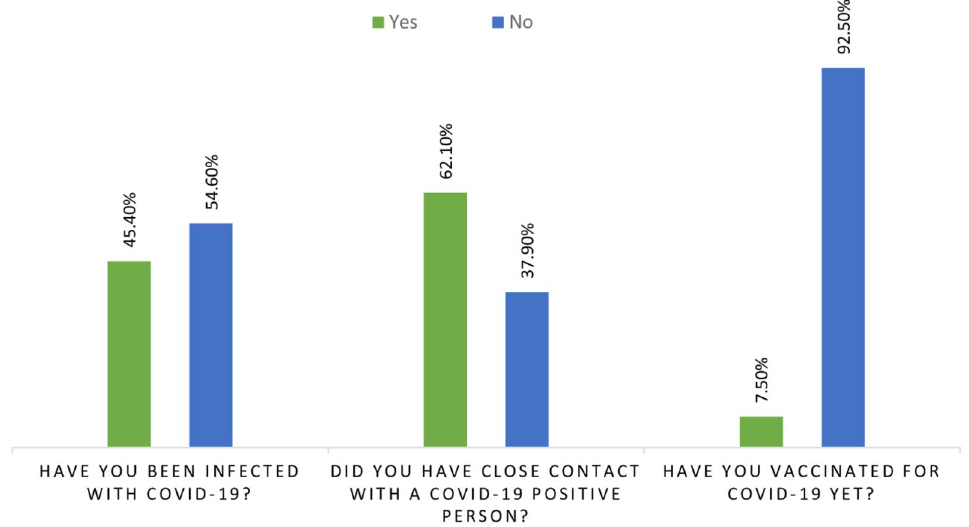
Figure 2. Participants’ declaration on COVID-19 infection state, their proximity contact with infected patients and the vaccination status of participants.